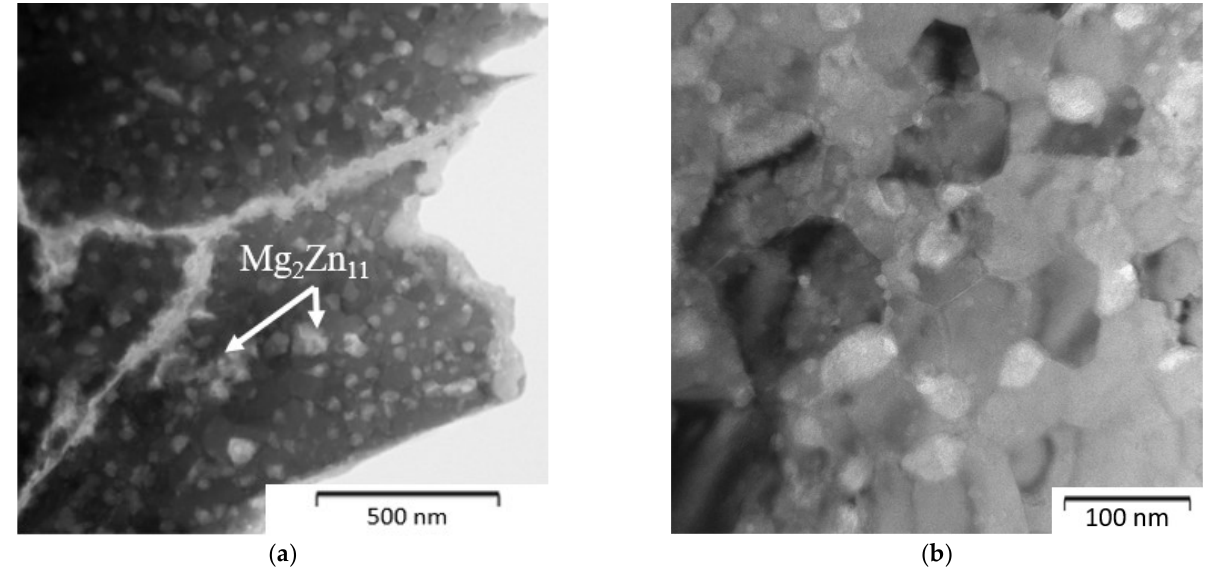
Figure 8. Microstructure of Zn-6Mg alloy compacted from mechanically milled powder (1200 RPM, 60 min) by SPS–TEM: ( a ) view of the powder particle, ( b ) detailed view of the internal structure.